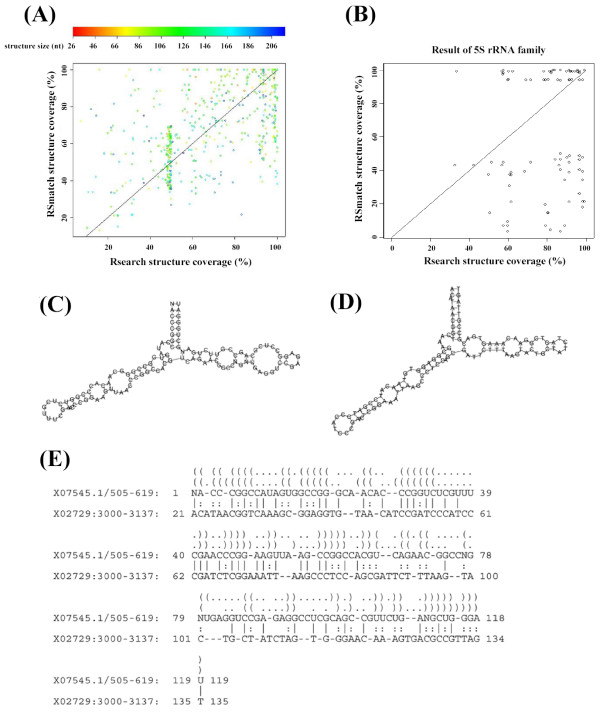
Performance comparison of Rsearch and RSmatch and an alignment of two 5S rRNAs. (A) Performance comparison for 64 RNA families. Different colors are applied to represent structures of different sizes. Each point corresponds to one alignment between a query structure and a subject structure. The x-axis is the percent of coverage by Rsearch and y-axis is the percent of coverage by RSmatch. (B) Performance comparison of 5S rRNA. A 5S rRNA was randomly chosen as the query structure and ten others as the subject sequences. The median value of the ten structure coverage values was then calculated. This process was repeated 100 times to generate 100 points for the graph. Therefore, each point represents one particular query structure. An example alignment of two 5S rRNA was shown: (C) the query structure is X07545/505-619; (D) the subject RNA is X02729; and (E) the detailed alignment by RSmatch.